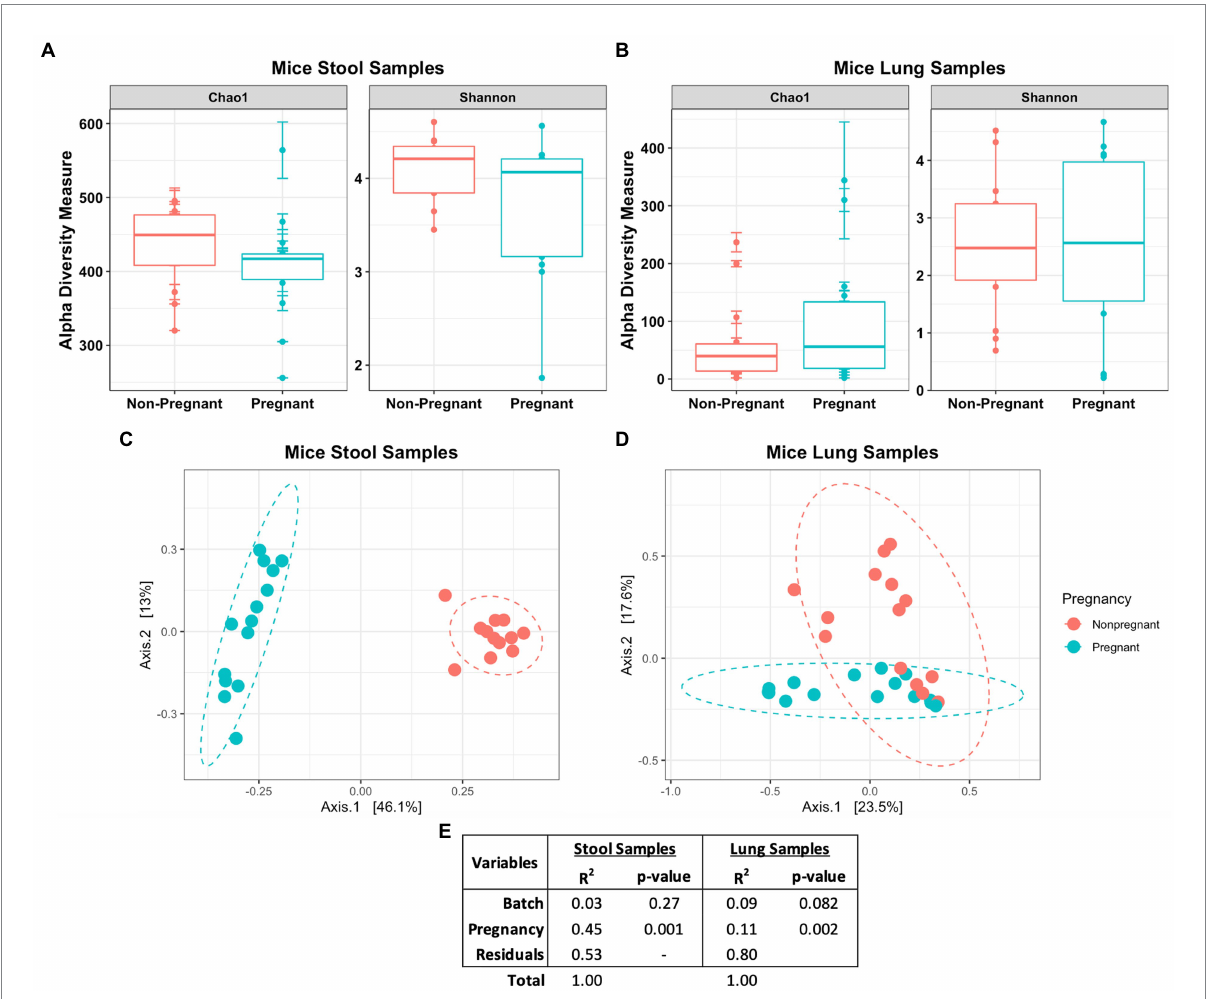
FIGURE 3 Diversity measures of pregnant and non-pregnant mice stool and lung samples. No significant difference was observed in the Chao1 and Shannon diversity index between the pregnant and non-pregnant groups in either the (A) stool or (B) lung samples. The unweighted Bray-Curtis PCoA shows the differences between the pregnant and non-pregnant groups in the (C) stool and (D) lung samples. (E) Statistical summary of the PERMANOVA test shows the variance and significance of the pregnancy and DNA batch extraction